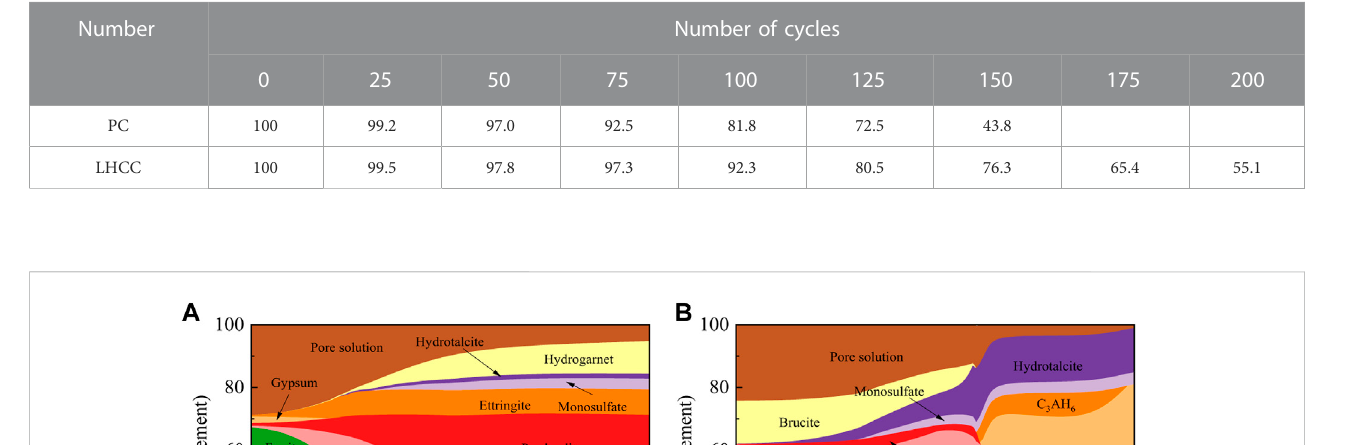
TABLE 6 Relative dynamic elastic modulus during 200 freeze and thaw cycles (%).